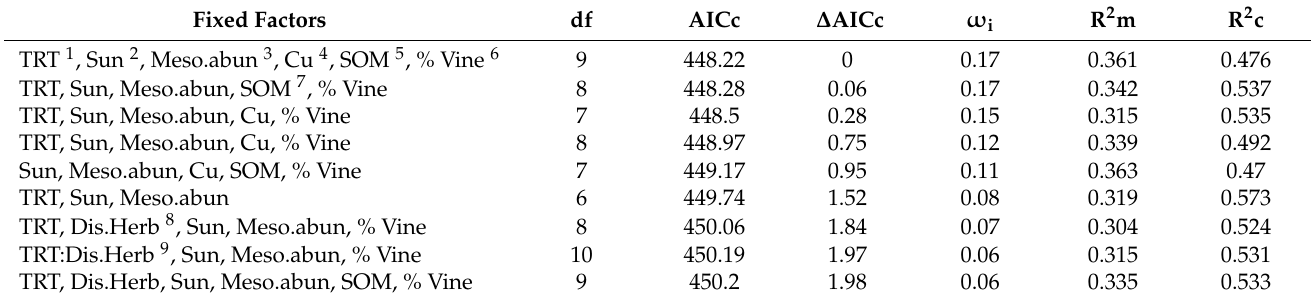
Table 2. Candidate models for carabid species richness used for model averaging, where df repre- sents the degrees of freedom used, AICc the second order Akaike Information Criterion, ∆ AICc the difference between AICc to the most parsimonious model, ω i the Akaike’s weight within the candidate models, R 2 m as the marginal R 2 value and R 2 c as the conditional R 2 value. Vineyard sites are used as random factors in all models